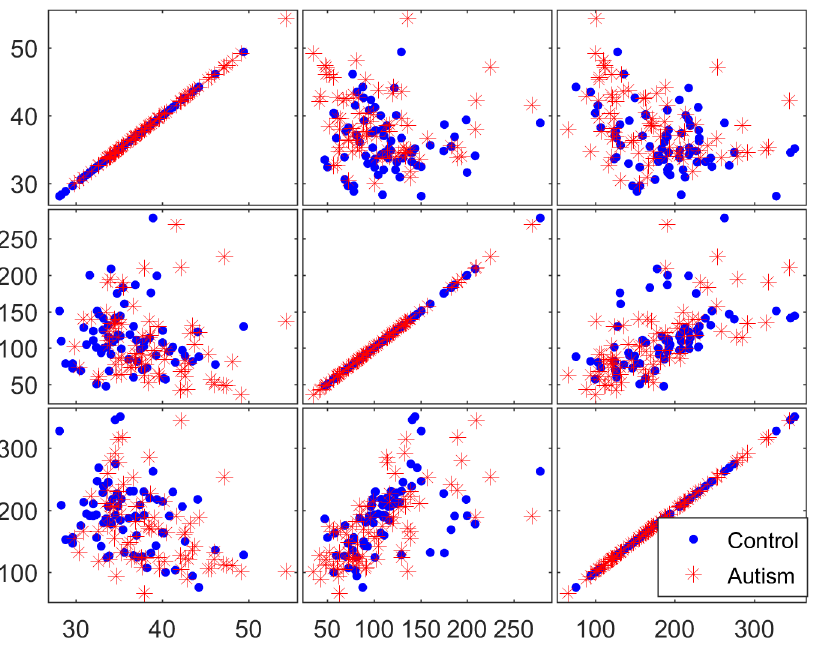
Fig 8. Matrix plots for three representative selectedgenes from the reduced dataset before the application of filter methods.